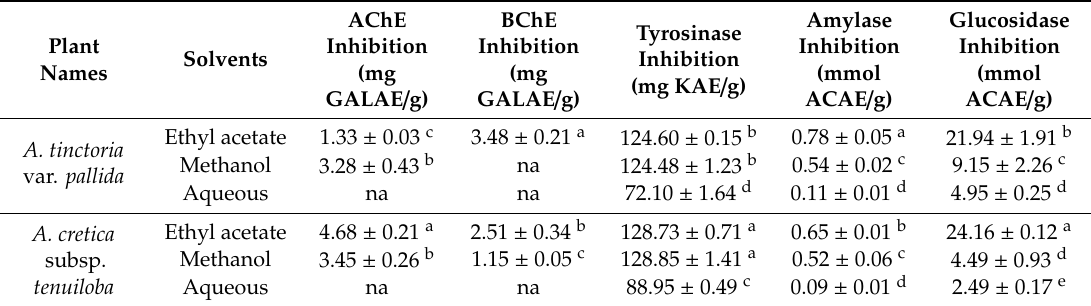
Table 4. Enzyme inhibitory activity of Anthemis extracts